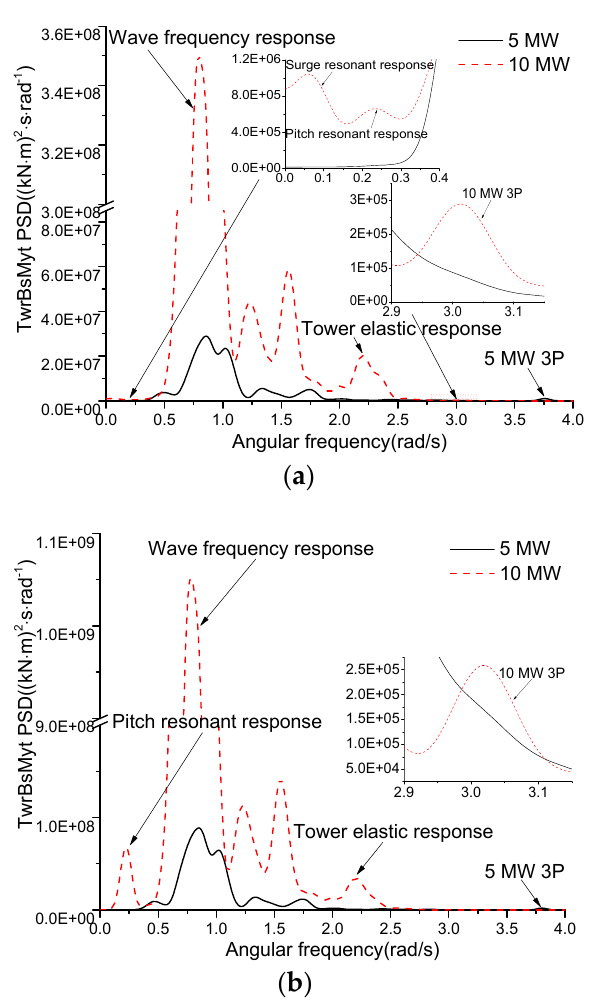
Figure 17. Comparison of the power spectra of TwrBsMyt response. ( a ) Power spectra of TwrBsMyt response for the LC3 case; ( b ) power spectra of TwrBsMyt response for the LC6 case.